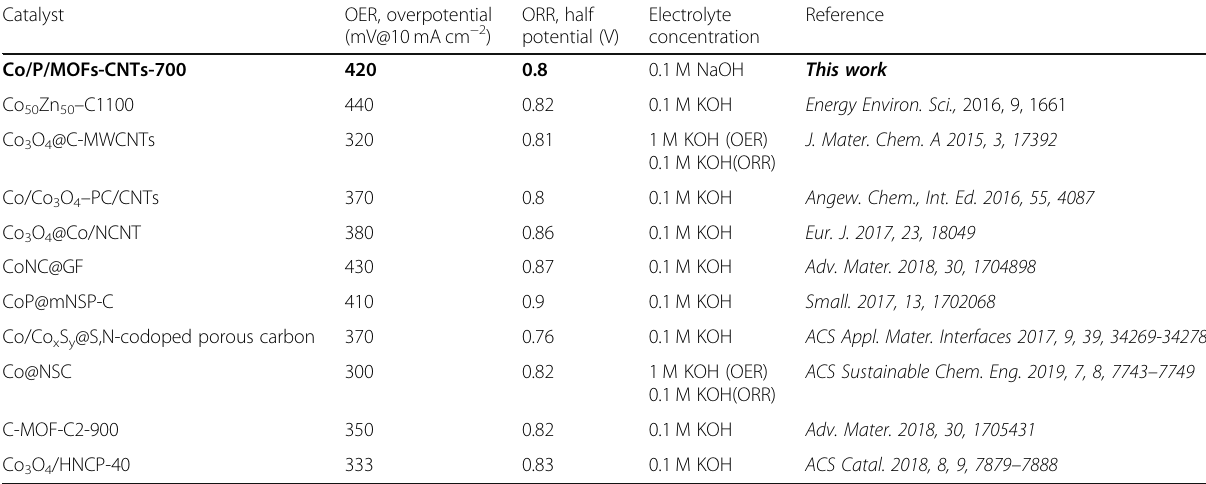
Table 1 The comparisons of OER and ORR activities of as-prepared Co/P/MOFs-CNTs-700 with other superior hetero-doped MOFS or MOF-derived catalysts previously reported Catalyst